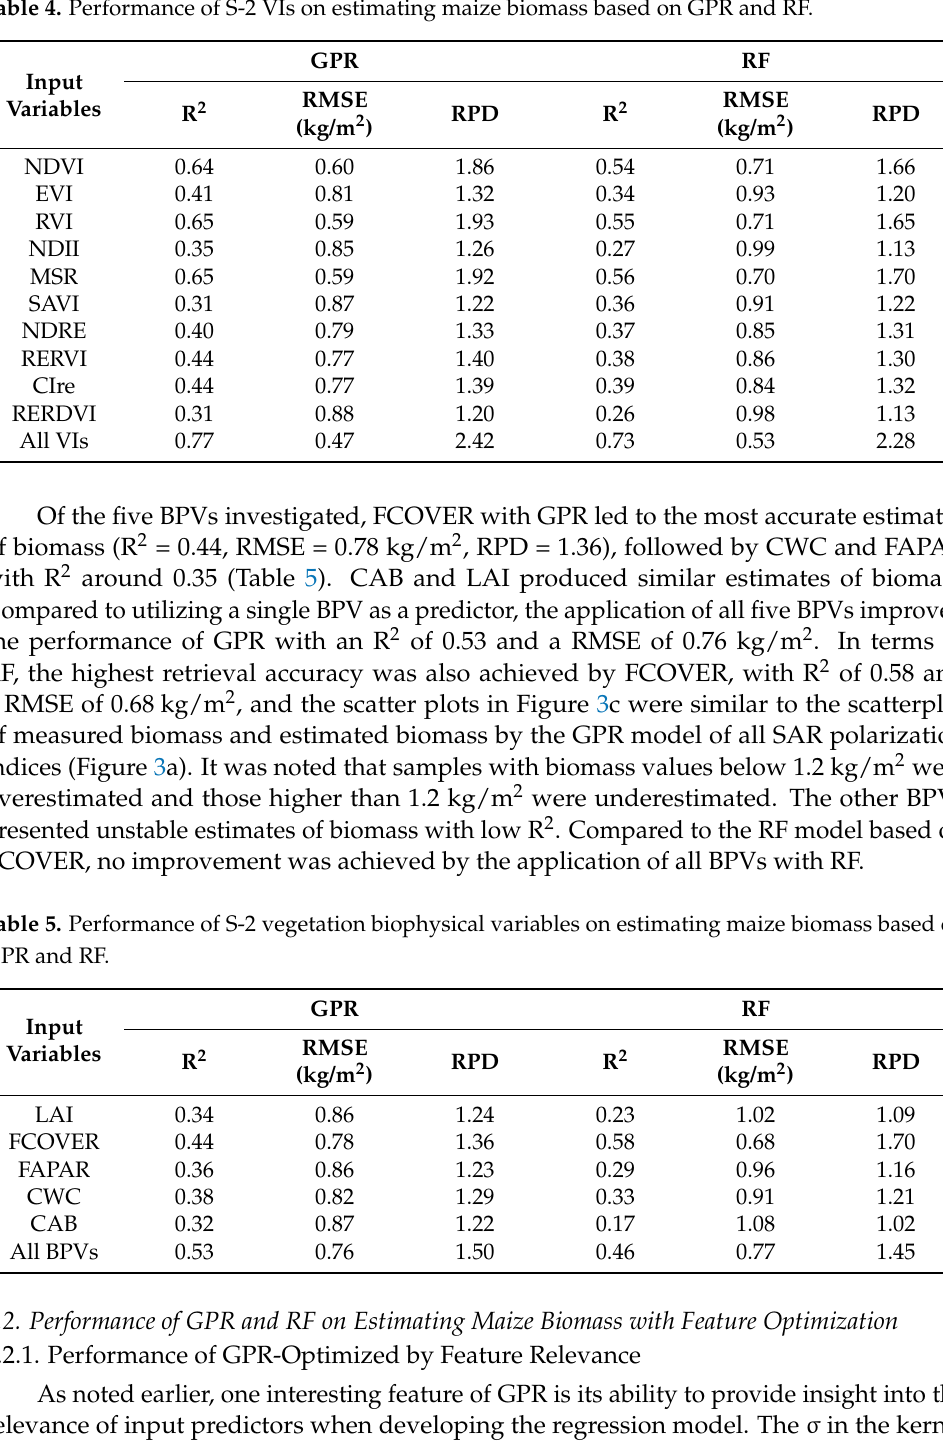
Table 4. Performance of S-2 VIs on estimating maize biomass based on GPR and RF.